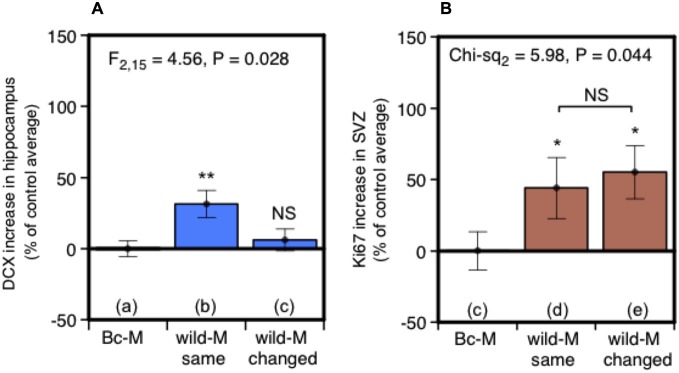
Effect of exposure to urine from the same male or sequentially changing males on hippocampal neurogenesis and SVZ cell proliferation. Increase in DCX-positive cell counts in the dentate gyrus (A) or Ki67-positive cells in the SVZ (B) in females exposed for 7 days to urine from the same wild-stock male (refreshed days 3, 5) or from three different wild-stock males in succession (changed days 3, 5), expressed as a percentage of the average cell count among control group females exposed to BALB/c male urine containing negligible darcin (mean ± sem, n = 6 per treatment). ANOVAs established differences between treatments within each experiment (A) parametric, (B) non-parametric), with planned comparisons of greater response to wild stock male urine than to the control group (*P < 0.05, **P < 0.01).